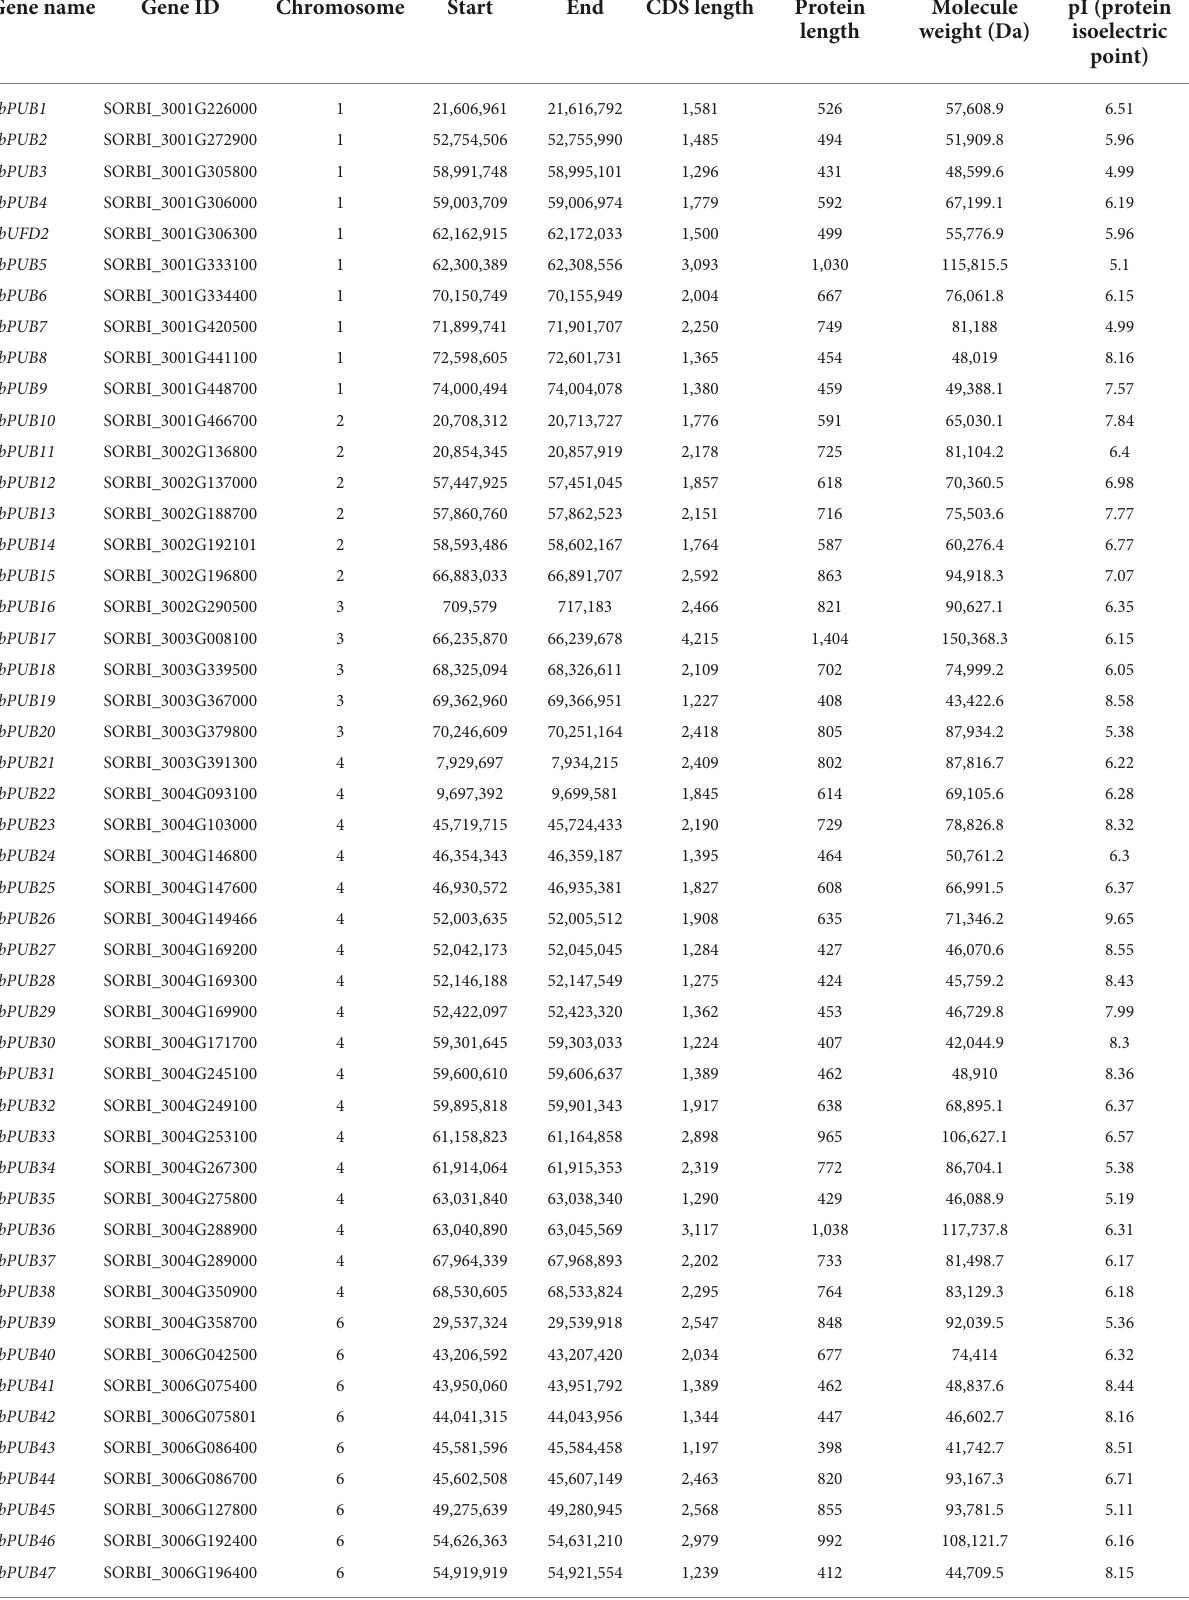
TABLE 1 Basic information of sorghum U-box